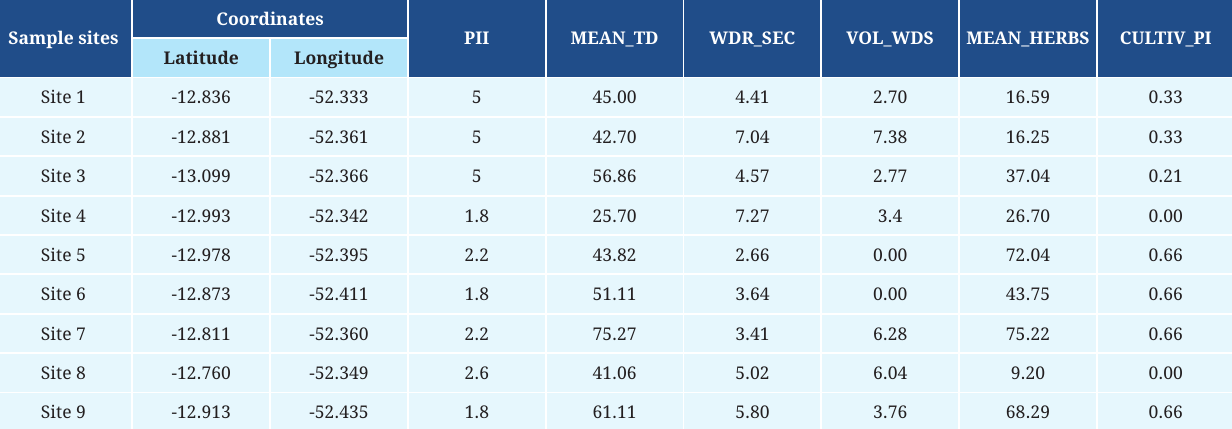
TABLE 2 | Values of the metrics selected to calculate the scores of the Physical Integrity Index in the Amazon, state of Mato Grosso. PII: Physical Integrity Index; MEAN_TD: mean thalweg depth (cm); WDR_SEC: width and depth ratio in the section; VOL_WDS: volume of woody debris in the stream /m 2 –size class 2; MEAN_HERBS: mean ground cover herbs; CULTIV_PI: cultivation proximity